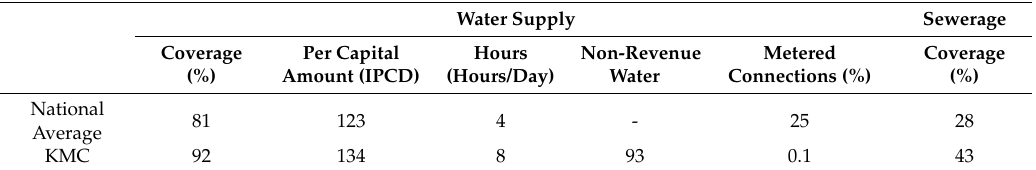
Table 4. Comparison between National and Municipal Urban Service Delivery Status in Kolkata Municipal Corporation